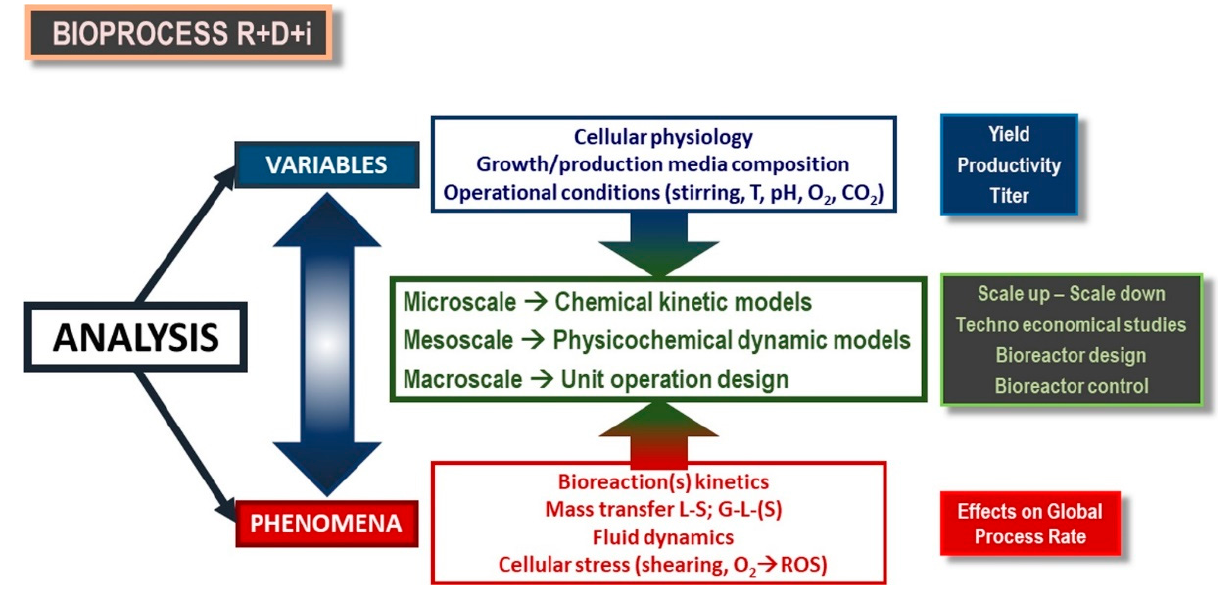
Figure 3. Dynamic phenomena coupling and modelling in a research, development and innovation (R+D+i) scheme for the implementation of a bioprocess.